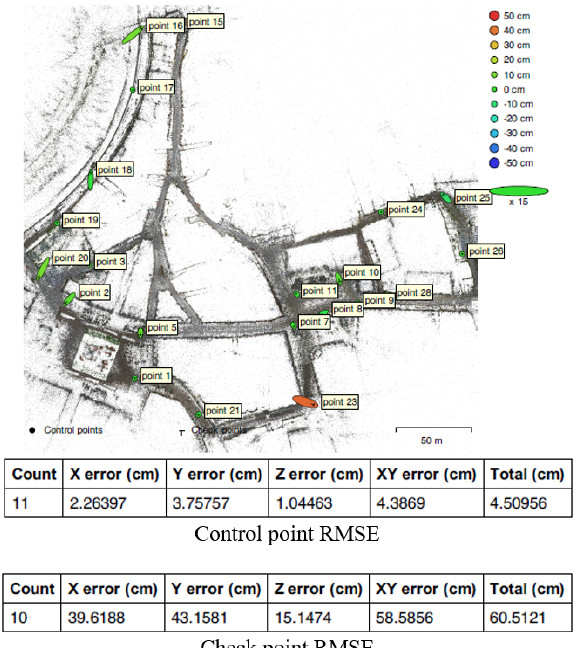
Figure 3: Statistics (in cm) after adding precise control points in the